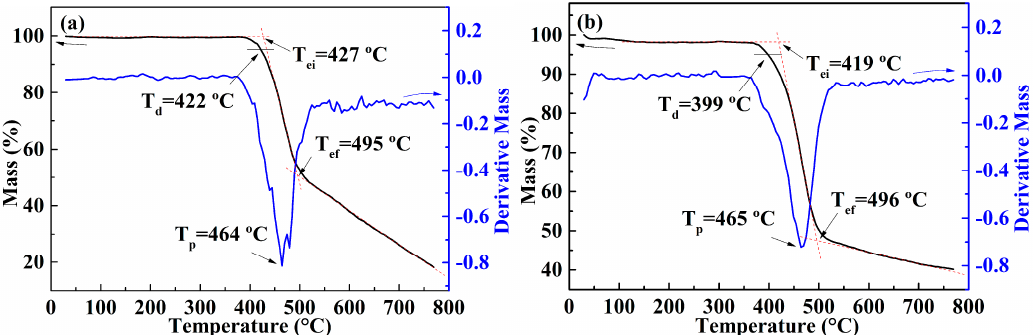
Figure 11. Thermogravimetric (TG) and differential thermogravimetric (DTG) curves for PITID-1 ( a ) and PITID-2 ( b ). Table 4. TG and DTG data for PITID-1 and PITID-2.